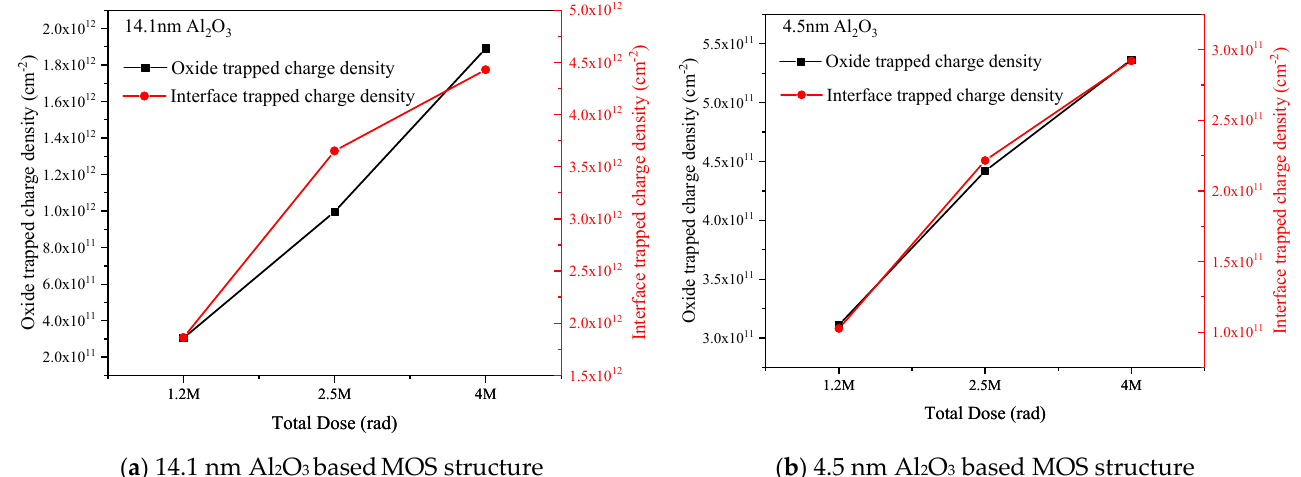
Figure 7. Oxide and interface trapped charge density in Al 2 O 3 based MOS structures.